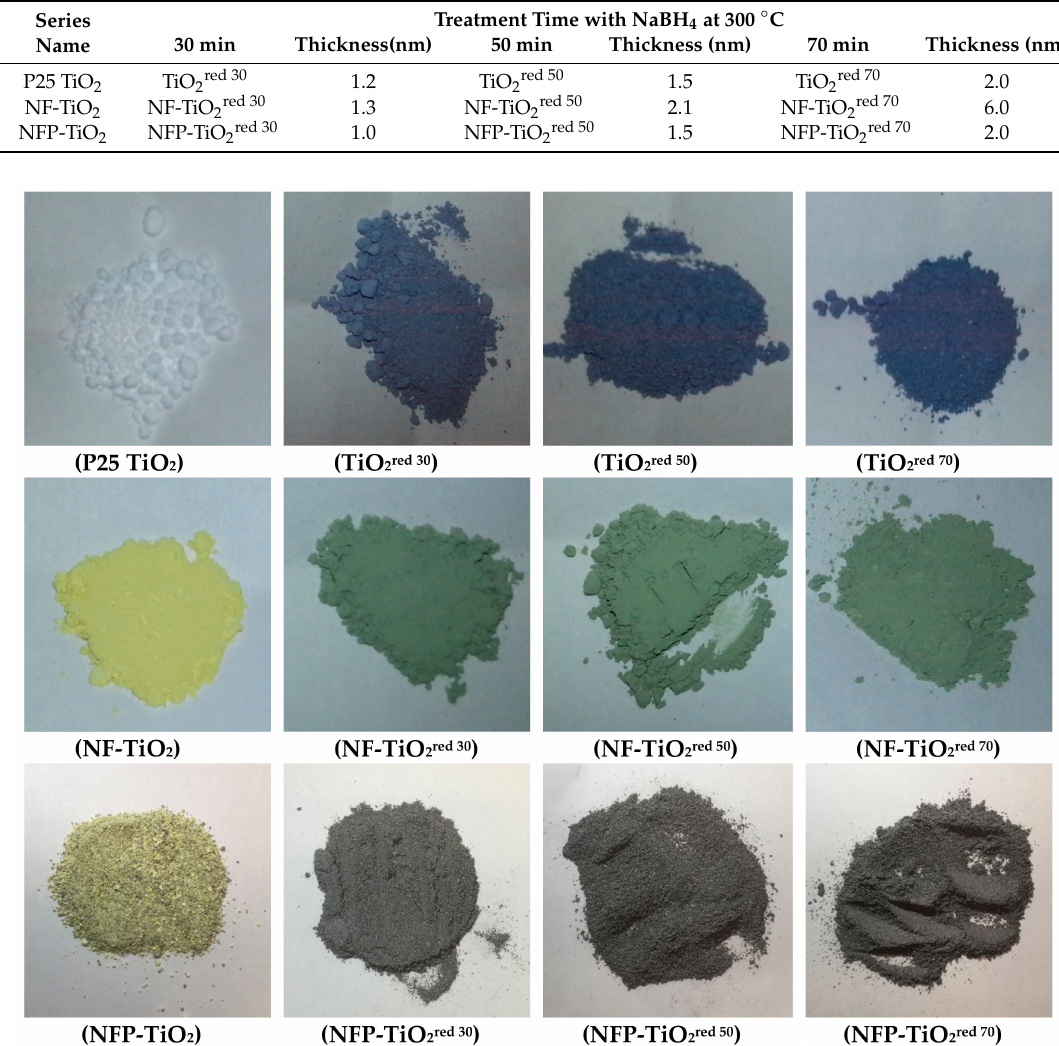
Figure 2. Color photographs of reduced TiO 2 synthesized by thermal treatment with NaBH 4